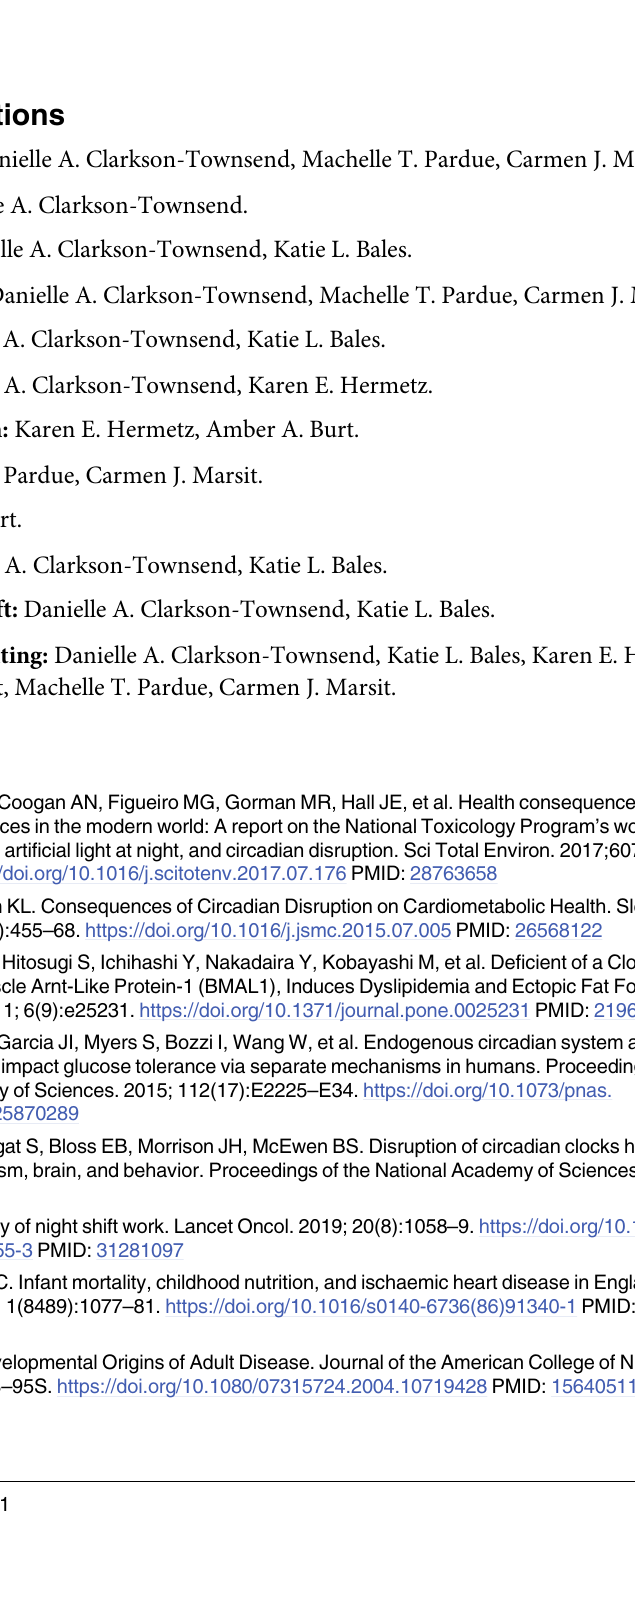
(negative log2FoldChange) in CD-exposed placenta tissue. To control for false discovery rate, p-values are adjusted using the Benjamini and Hochberg (BH, q-value) method (padj). S5 File. Gene list of the gene IDs of the DE light treatment analysis entered in the EnrichR pathway analysis and results when searched in the Mouse Gene Atlas, ChEA, KEGG, and GO term